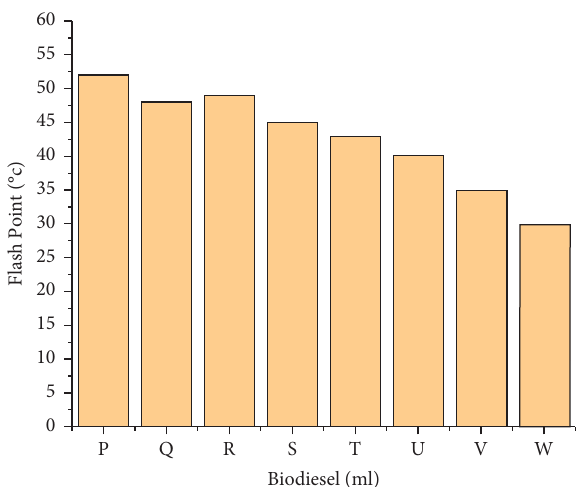
Figure 3: Te fash point test results with varying biodiesel volumes.